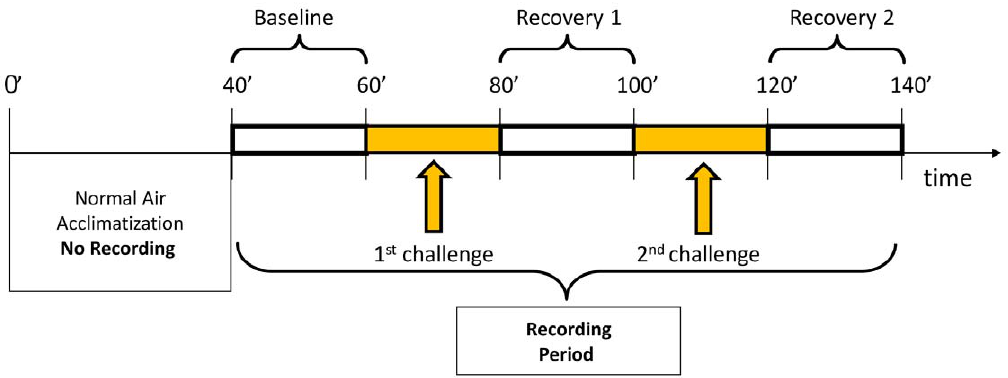
Figure 1. Scheme of the respiratory protocol. During ‘baseline’ and ‘recovery’ periods, subjects inhaled normal air. During ‘challenge’ periods subjects were exposed to one type of air mixture: 6% CO 2 -enriched air, or 10%O 2 air, or normal air.